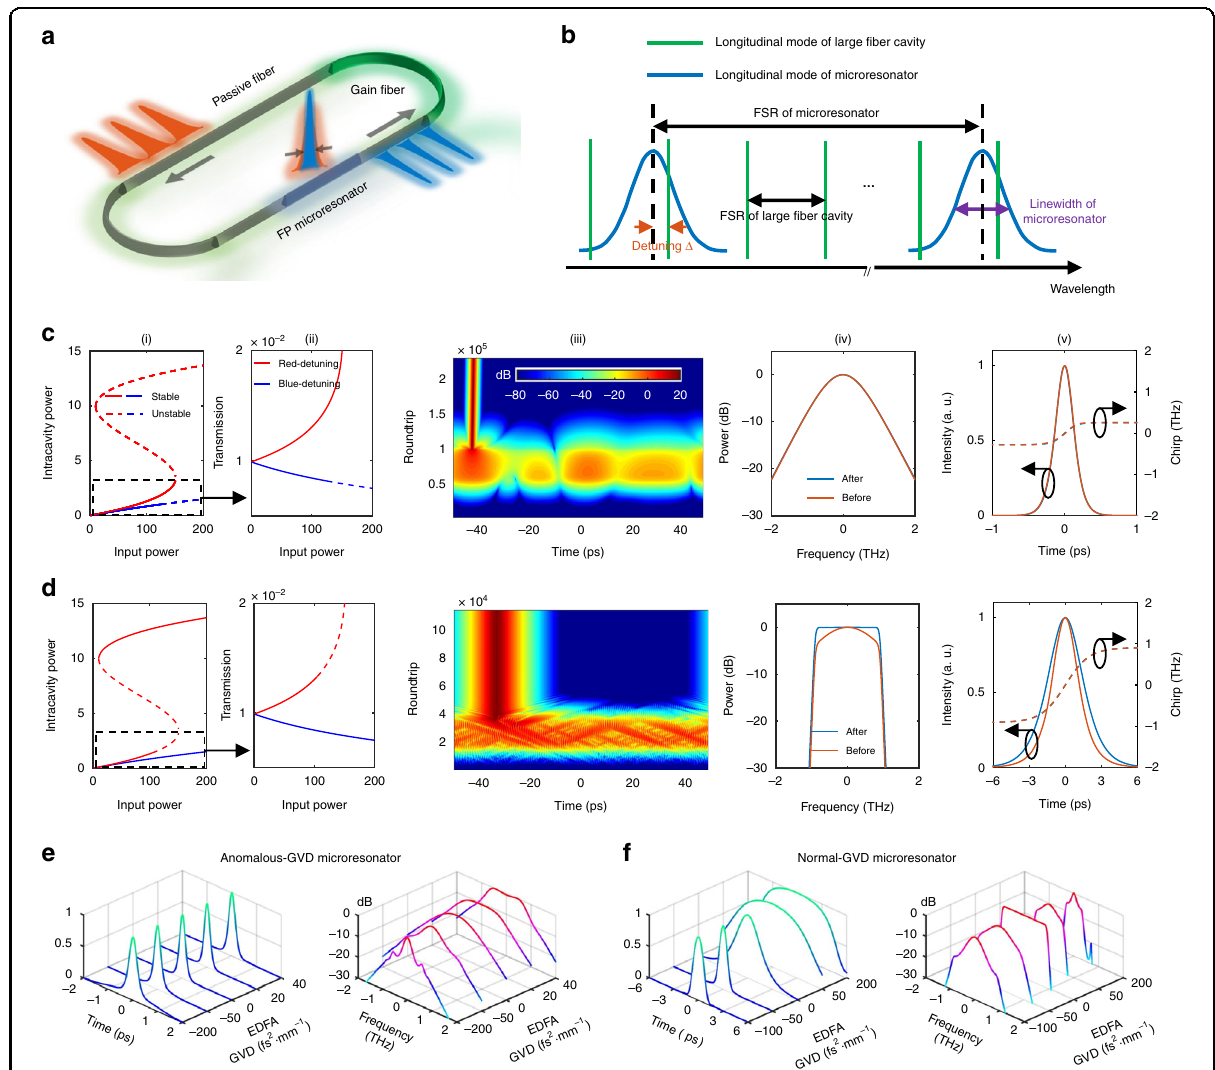
Fig. 1 Mode-locking principle and theoretical analysis. a Scheme for dissipative soliton generation in microresonator- fi ltered fi ber lasers. A microresonator is nested in a fi ber laser cavity. b Cold-cavity spectral distribution, showing the FSRs of the large fi ber cavity and microresonator resonances, and corresponding linewidth of the microresonator. The detuning represents the relative position of the oscillating mode within the microresonator resonance. In b , red detuning is shown. c , d Simulations for microresonator with anomalous GVD ( c ) and normal GVD ( d ). The nonlinearity, GVD and gain dispersion of the EDFA are neglected. Sub fi gure (i): bifurcation of homogeneous states. Sub fi gure (ii): transmission of the lower branch. Sub fi gure (iii): self-initiation of dissipative soliton from ASE. Sub fi gures (iv) and (v): spectra and pulse pro fi les before and after the microresonator. e , f Simulated mode-locked pulse pro fi les (left) and spectra (right) for microresonators with anomalous GVD ( e ) and normal GVD ( f ) by varying the GVD of the